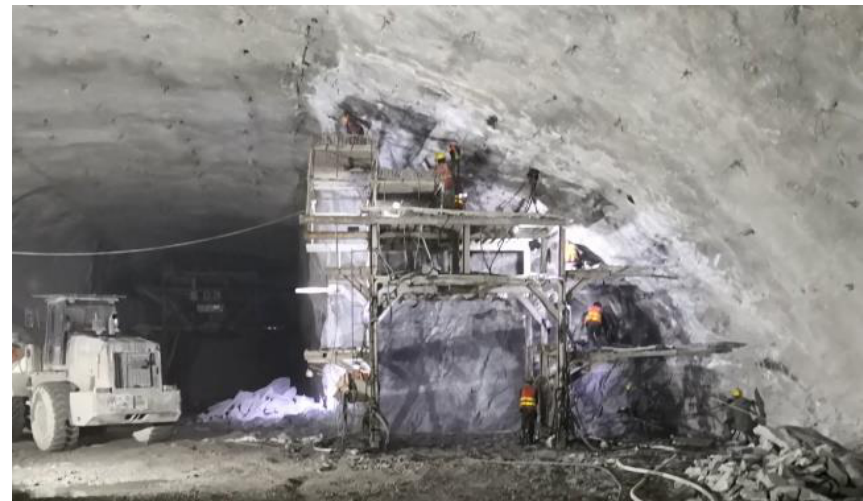
Figure 6. Construction site of the sidewall excavation.